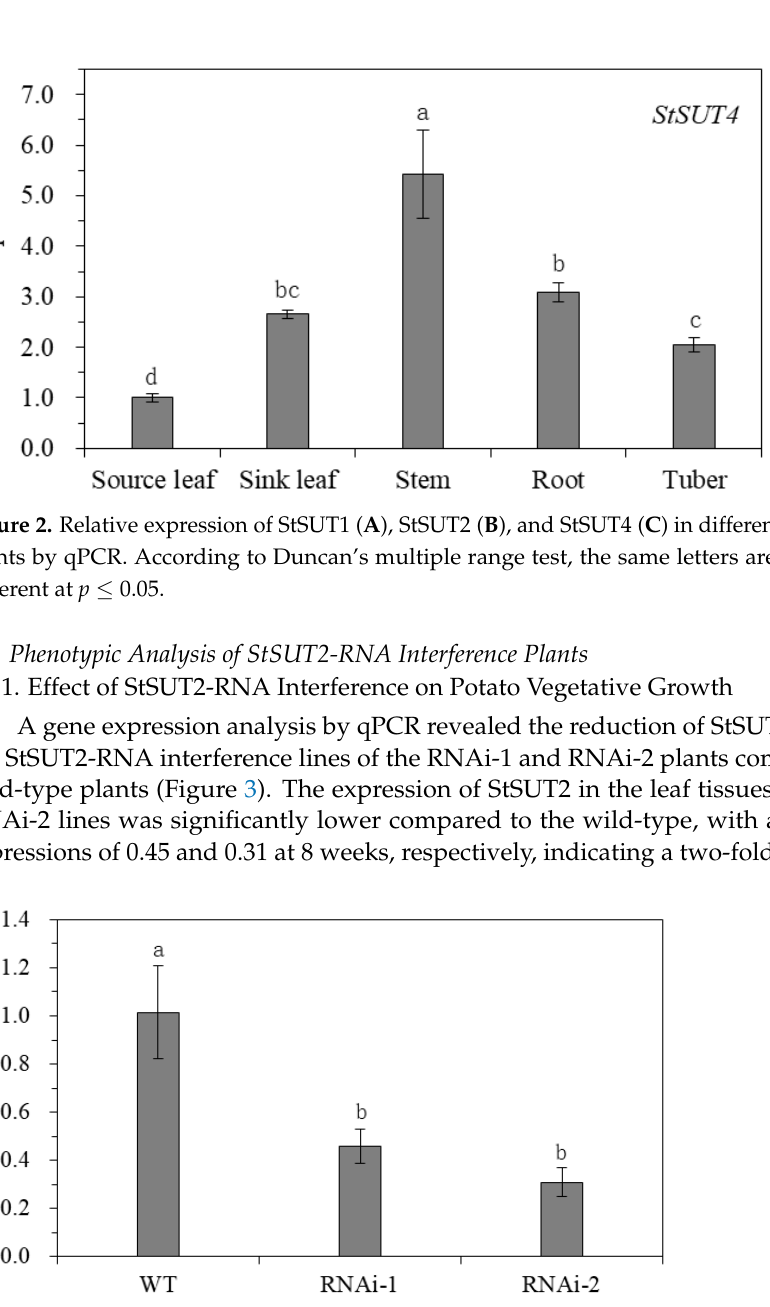
Figure 3. StSUT2 expression level in the leaf of StSUT2-RNA interference lines. According to Duncan’s multiple range test, the same letters are not significantly different at p ≤ 0.05.